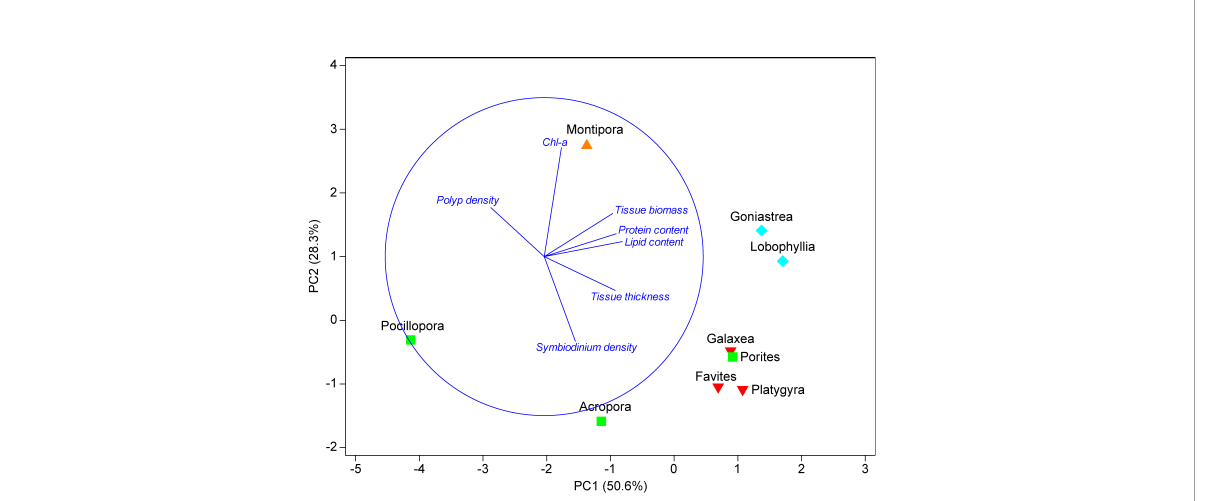
FIGURE 5 Principal components analysis (PCA) plot of multivariate analysis of coral genera nutritional value of prey data: lipid content, protein content, tissue biomass, Symbiodinium density, Chl-a content, tissue thickness, and polyp density. PCA analyses are based on the data obtained from the Coral Trait Database and published studies. The missing values were fi lled using a linear regression. The genus Echinophyllia was excluded in these analyses because the data were not available. The triangle, upside-down triangle, square, and diamond symbols indicate the four groups of signi fi cant different coral genera based on the SIMPEROF